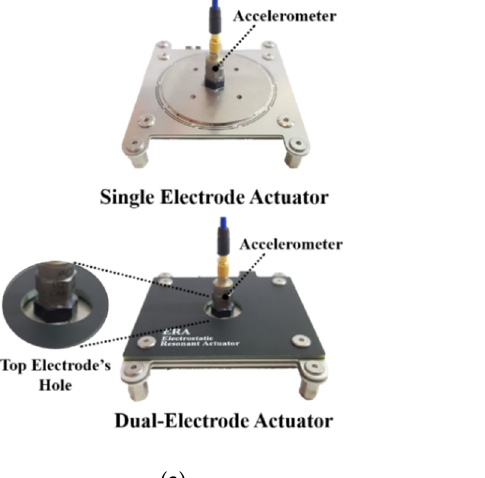
( b ) Figure 6. Input signals used in the experimental setup: ( a ) single-electrode ERA offset sine input; ( b ) dual-electrode ERA upper and lower electrode inputs. As seen in Figure 7, the dual-electrode actuator’s resonant frequency was slightly higher than that of the single-electrode actuator because of the variations in their manufacturing discussed earlier. The figure further shows that the dual-electrode actuator produced a higher maximum acceleration of 14.32 g-forces at its resonant peak, compared to the single-electrode actuator which produced a maximum of 8.27 g-forces at its resonant frequency. Thus, the dual-electrode ERA with both electrodes activated produced a significantly greater vibration intensity compared to the single- electrode ERA, producing over 6 g-forces more, or a 73% increase, at their maxima. The results